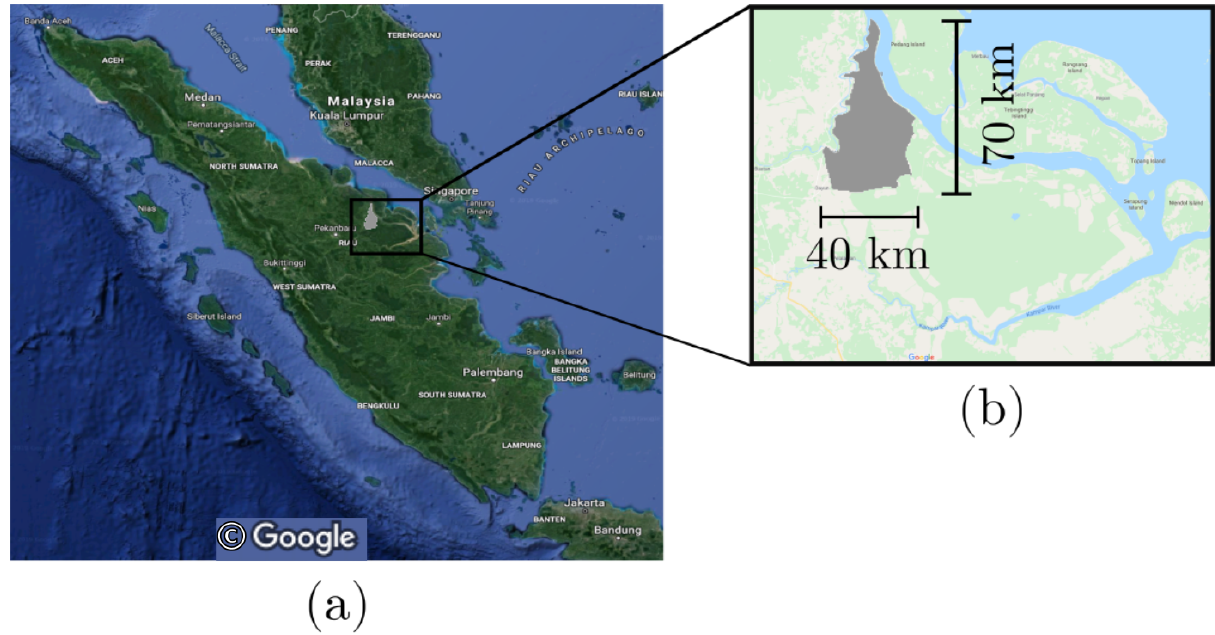
Figure 1. (a) Map of Sumatra, Indonesia, with the study area shown in gray. (b) Detailed view of the study area. Map data: © Google, Maxar Technologies. Table 1. Terms and symbols used in the study.